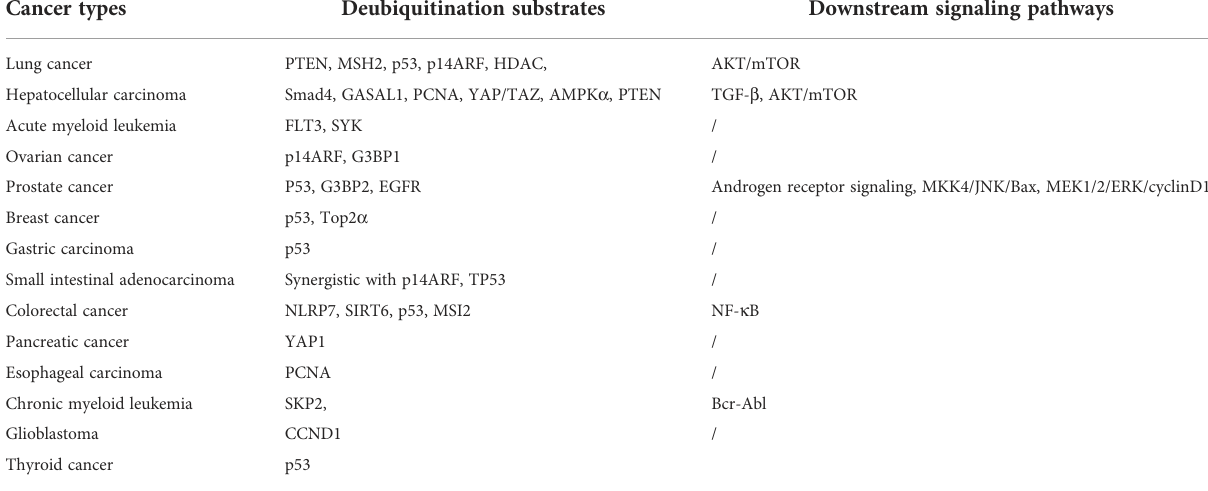
TABLE 1 The deubiquitination substrates and downstream signaling pathways of USP10 in different cancer types. Cancer